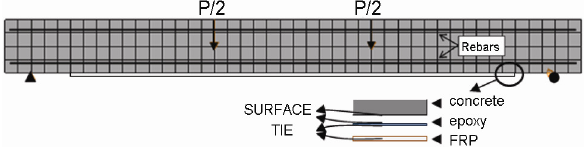
Fig. 8. Traction-separation model for interface